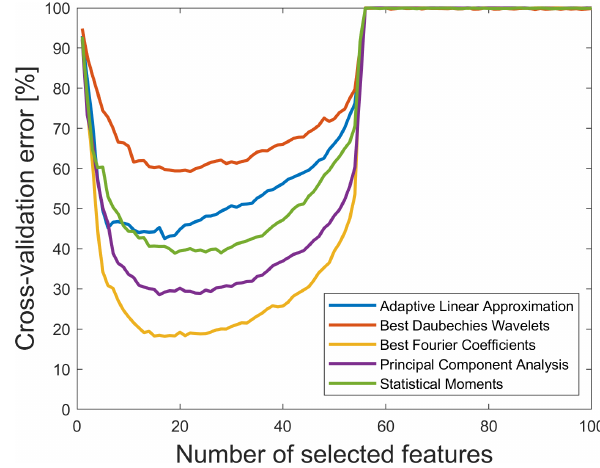
Figure 6. The 10-fold cross-validation error vs. number of se- lected features for the original 2kHz data set without time shift us- ing RFESVM as selector. For a better visibility, only results with RFESVM as selector are